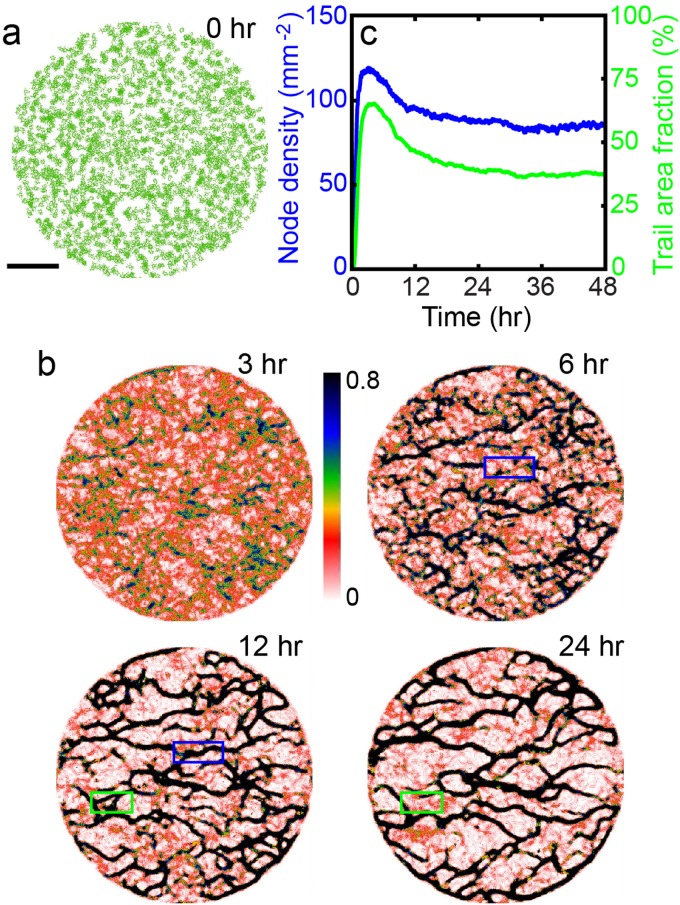
Trail network formation in a population of interacting model cells.(a) Initial state showing 2,000 cells (Kdecay = 0.04), (b) Sequence of pseudo-color images of q attractant showing the development of a network of trails, and (c) Node (i. e. trail junctions) density and the areal percentage of trails vs. time. Even for the long-term steady state, the network is slowly but constantly evolving with the formation of new trails and the decay of rarely visited portions of trails. The pair of blue (green) boxes in (b) illustrates a case of an emerging (decaying) trail in time.